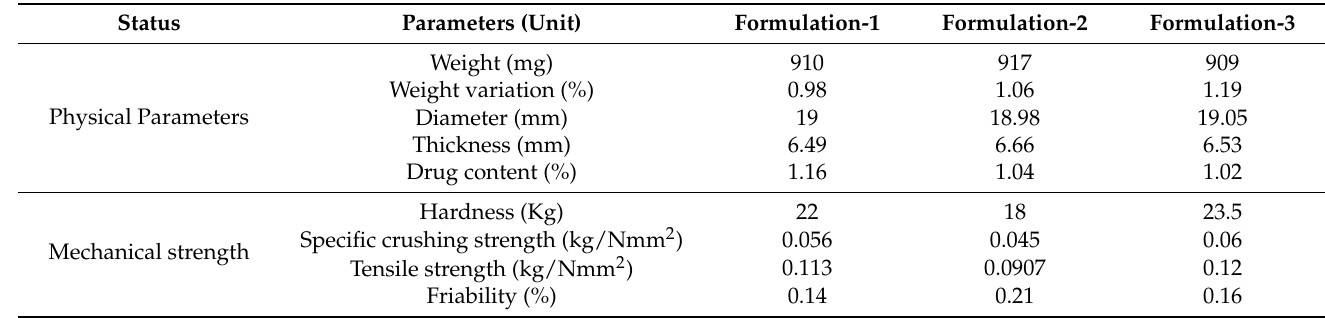
Table 5. Post-compression evaluation of polymeric matrix